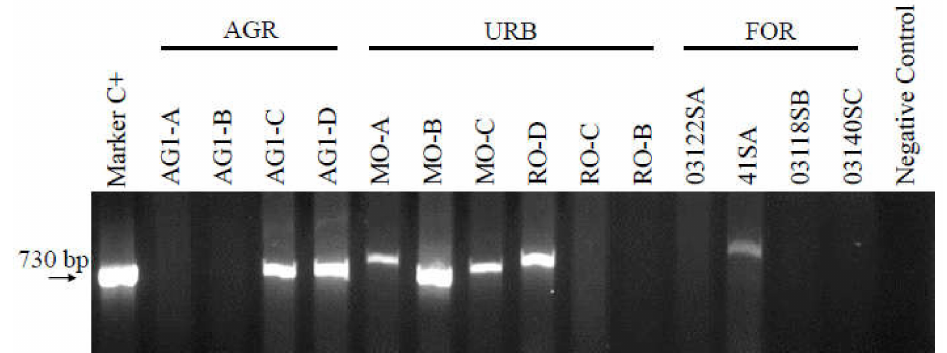
Figure 1. PCR amplification of agricultural (AGR / AG1-A, AG1-B, AG1-C, AG1-D), urban (URB / MO-A, MO-B, MO-C, RO-D, RO-C, RO-B) and forest samples (FOR / 03122SA, 41SA, 03118SB, 03140SC) of Mori / Rovereto / Monticolo-Montiggl respectively, using S. enterica , as both size marker and positive control (Marker / C + at 730 bp). Further information about each sample are available in Table S1, Table S2, Table S3, Table S4 of Supplementary